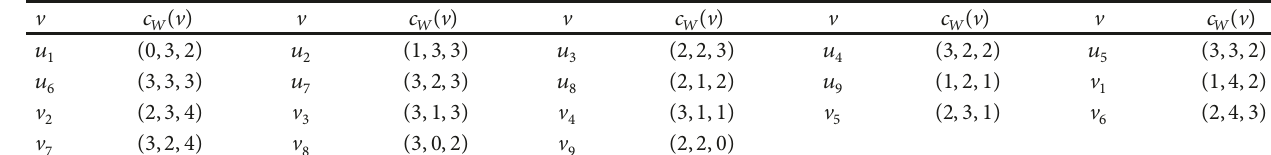
Table 6: The code 𝑐 𝑊 ( V ) of V with respect to 𝑊 = {𝑢 1 , V 8 , V 9 } in 𝑃(9, 4) .